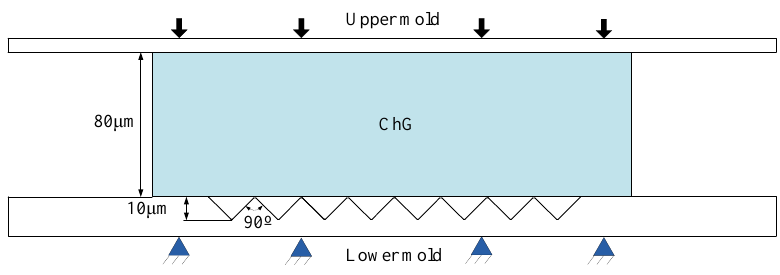
Figure 12. A two-dimensional simulation model of microstructures molding [30]. Two representative points are selected in the simulation model of the ChG, as shown in Figure 13. The point A is at the interface between the ChG and the top of the mold microstructures. Point B is at the interface between the ChG and the mold surface without microstructures.